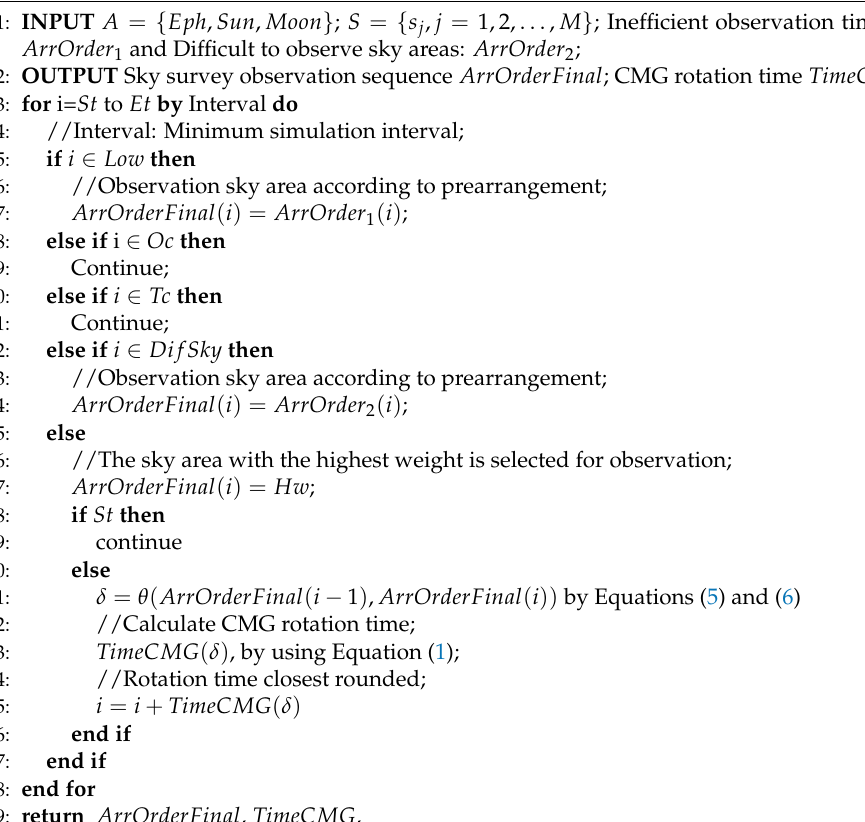
Algorithm 4 Overall Arrangement